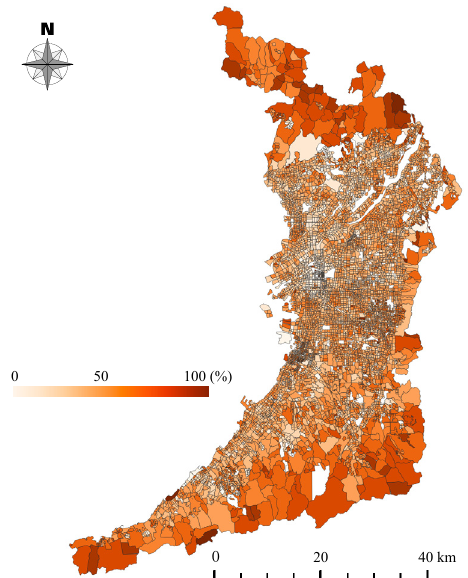
Figure 13 . Percentage of households with relatives aged 65 and over in 2015, as an instance.